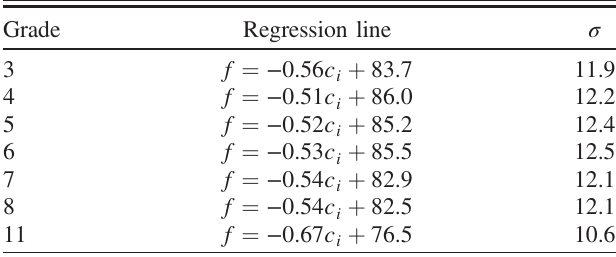
TABLE II. Regression lines for passing fraction p i versus poverty concentration c i plots of each grade level [Figs. 1(b) and 3], and the respective standard deviations σ . Data are for 2013 mathematics exams and apply to Illinois schools outside of Chicago. Regression lines are used to compare Chicago school programs to non-Chicago schools, as shown in Fig. 4(b).